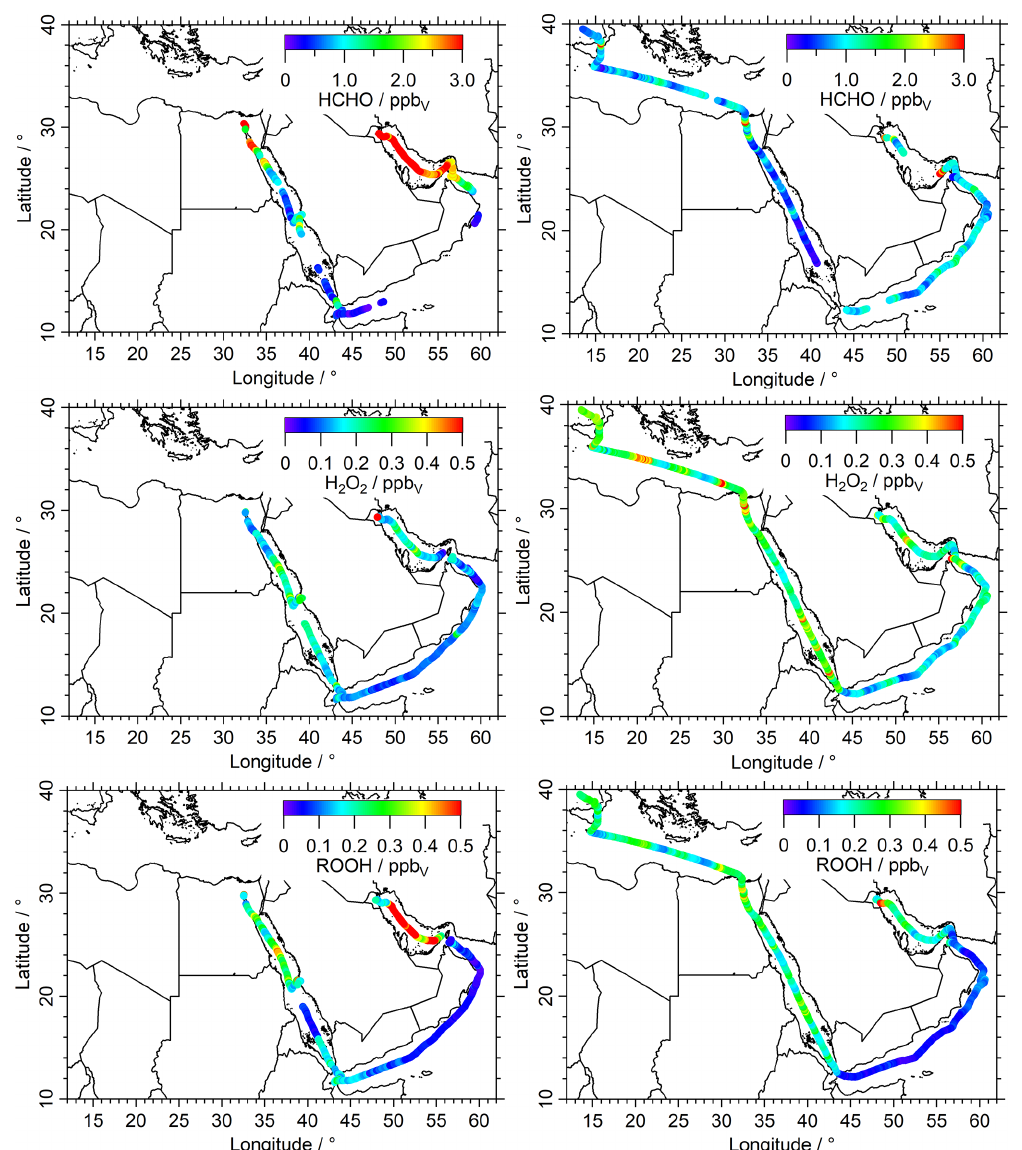
Figure 2. Overview and data coverage of HCHO, H 2 O 2 and organic hydroperoxide measurements during both legs of the AQABA ship campaign (graphs on the left represent the first leg). Contaminated HCHO data (e.g., by ship exhausts) were removed from the dataset with a stack filter (based on the NO, CO and SO 2 observations); therefore there is less HCHO data coverage during the first leg in the Arabian